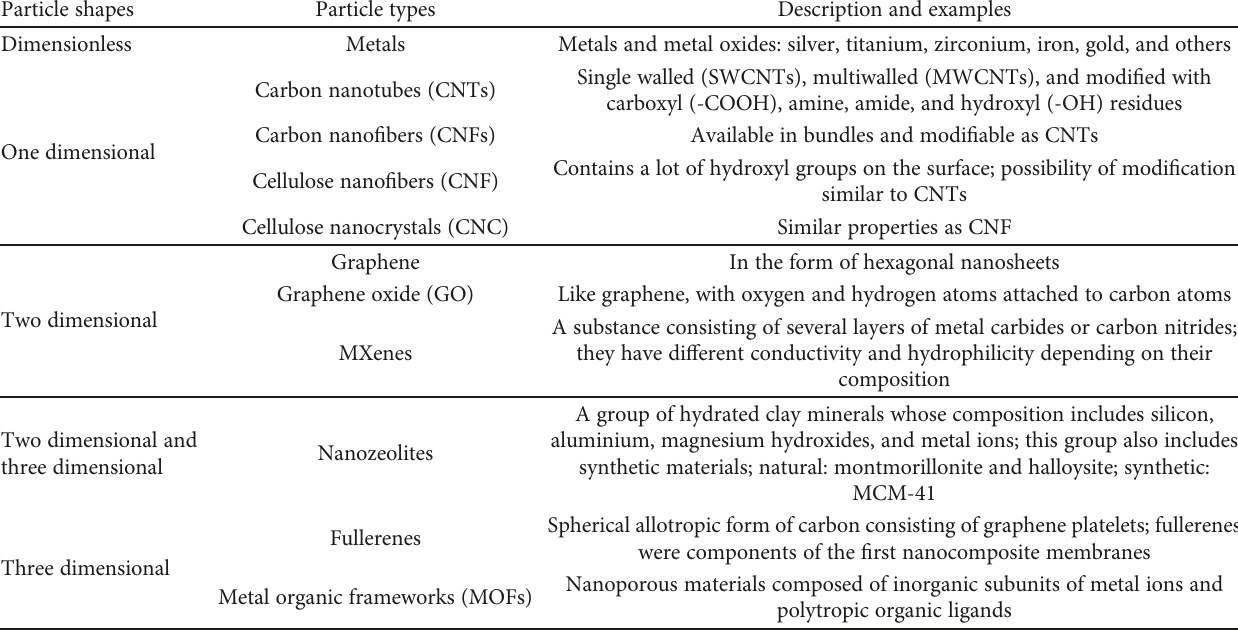
Table 3: Division of nanoparticles used in the preparation of nanocomposite membranes [18, 20, 38, 39]. Particle